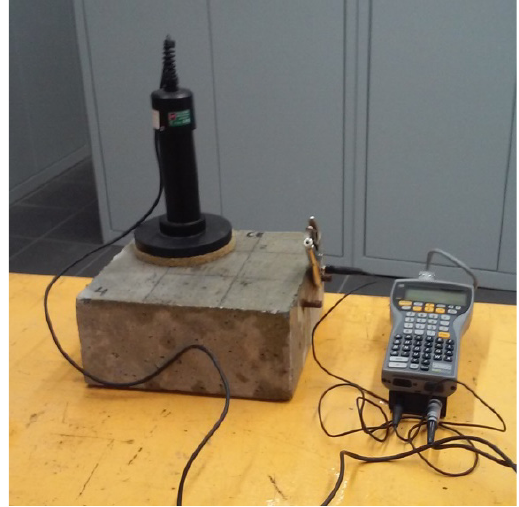
Figure 5. Photo of measurements carried out on one of the tested specimens.